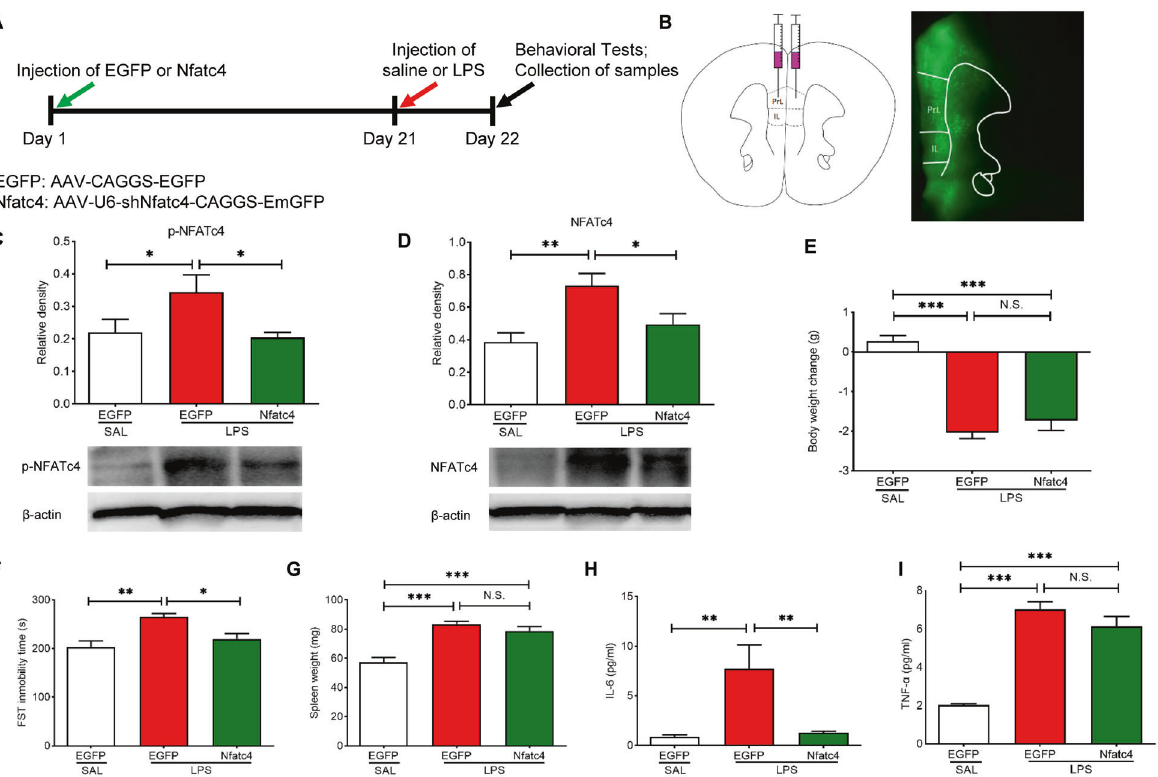
Fig. 5 Effects of NFATc4 knockdown on depression-like phenotype, spleen weight and in fl ammatory cytokines after LPS injection. A Treatment schedule. AAV-U6-shNfatc4-CAGGS-EmGFP or AAV-CAGGS-EGFP was injected bilaterally to mPFC 21 days prior to saline (10 ml/ kg) or LPS (1.0 mg/kg) injection. Locomotion test and FST were performed 23 and 24 h after the injection of saline or LPS, respectively. Blood, spleen and mPFC were collected after behavioral tests. B Schematic of AAV-mediated Nfatc4 down expression in the mPFC. The diagram shows the AAV constructs and stereotaxic injection of AAV into the mPFC. C The protein expression of phosphorylated NFATc4 (p-NFATc4) in the mPFC (one way ANOVA: F 2,26 = 5.440, P = 0.011). D The protein expression of total NFATc4 in the mPFC (one way ANOVA: F 2,26 = 6.673, P = 0.005). E Body weight change (one way ANOVA: F 2,26 = 36.65, P < 0.0001). F FST (one way ANOVA: F 2,26 = 8.409, P = 0.002). G Spleen weight (one way ANOVA: F 2,26 = 23.94, P < 0.0001). H Plasma levels of IL-6 (one way ANOVA: F 2,26 = 8.580, P = 0.001). I Plasma levels of TNF- α (one way ANOVA: F 2,26 = 79.13, P < 0.0001). The data represent mean ± S.E.M. (n = 9 – 11). * P < 0.05, ** P < 0.01, *** P < 0.001. N.S., not signi fi